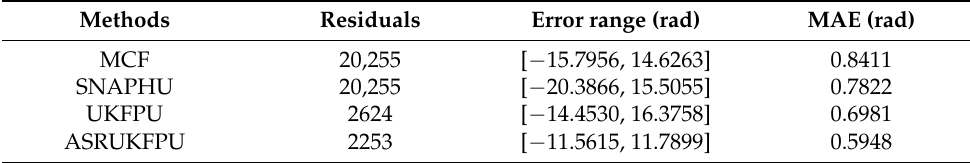
Figure 10. Experimental results for TerraSAR-X/TanDEM-X data (unit is rad): ( a ) PU result obtained by MCF; ( b ) PU result obtained by SNAPHU; ( c ) PU result obtained by UKFPU; ( d ) PU result obtained by ASRUKFPU. Table 2. The evaluation results of different methods on TerraSAR-X/TanDEM-X data.